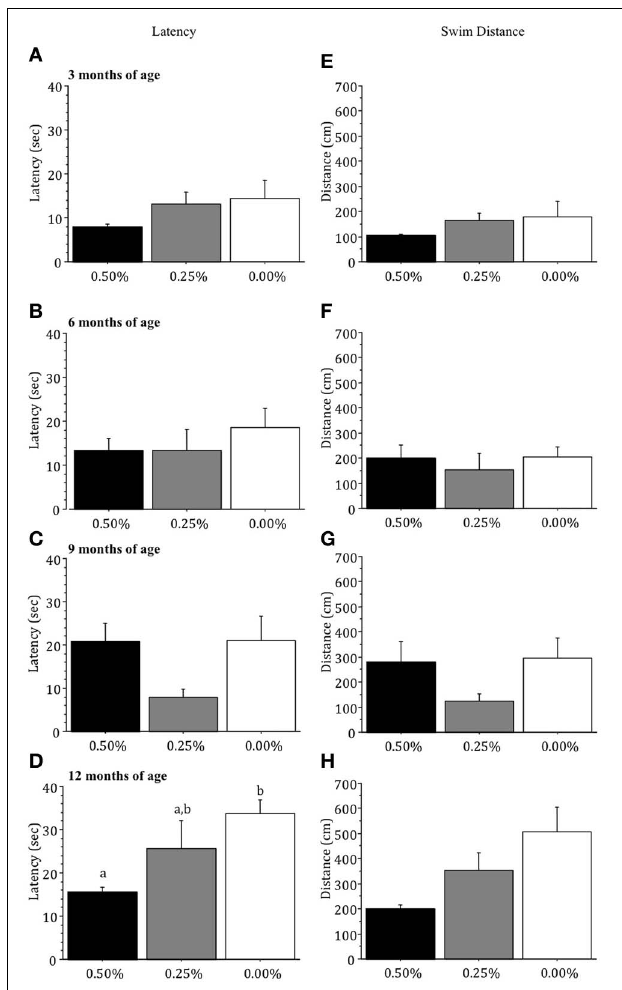
FIGURE 3 | Mean ( ± S.E.M.) latency (sec) and swim distance (cm) to find the visible platform in the Morris water maze for mice receiving 0.50, 0.25, and 0.00% Timoptic-XE at 3 (A,E), 6 (B,F), 9 (C,G), and 12 (D,H) months of age. Different letters indicate significant differences between groups ( p < 0 .